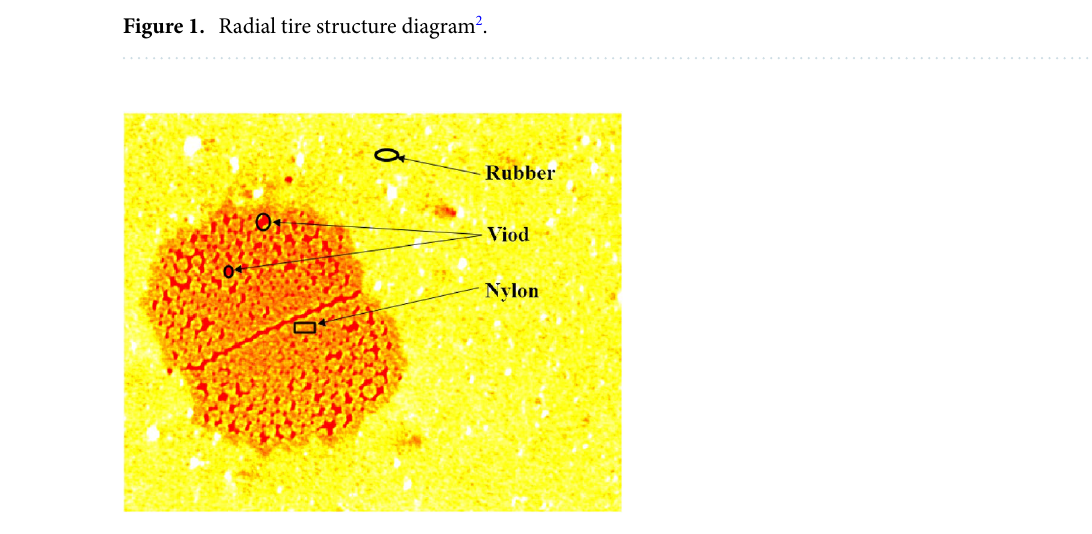
Figure 2. Microstructure of rubber, nylon and air in